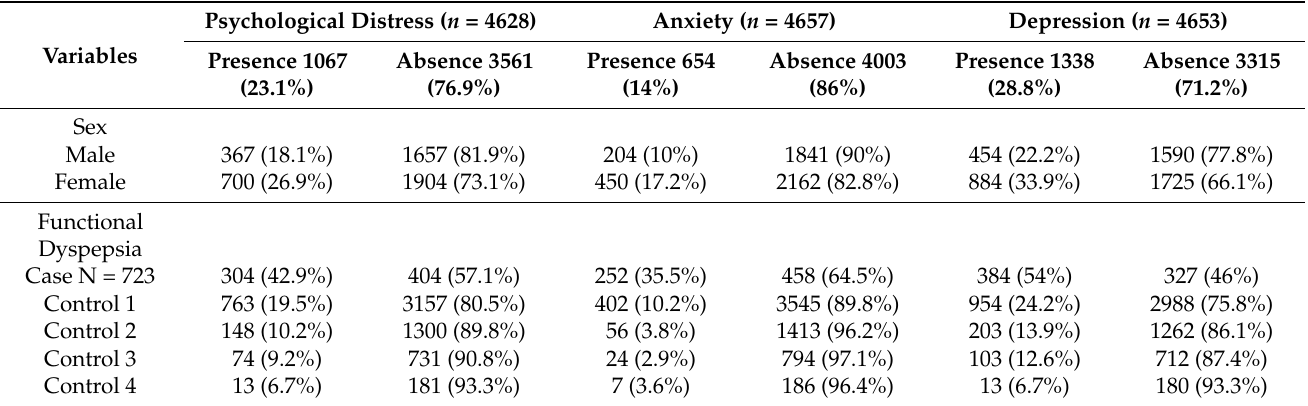
Table 2. Demographical and psychological features of